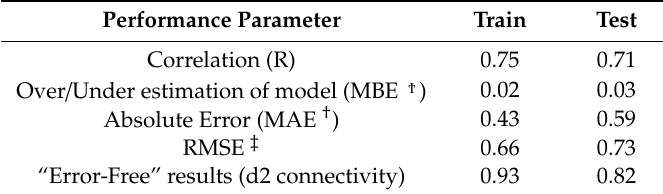
Table 2. Artificial neural network (ANN) performance values on construction of stomatal conductance index.